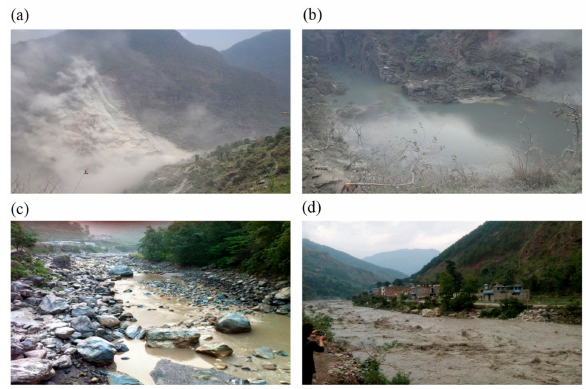
Figure 9. ( a ) Natural landslide dam formation on 24 May 2015 (~56 km upstream of dam), ( b ) lake formation after the blockage of the river, ( c ) downstream fluvial discharge after the blockage of the river, and ( d ) extreme fluvial discharge after breaching of the landslide dam on 25 May 2015 (Source: http: // kathmandupost.ekantipur.com / news / 2015-05-24 / blocked-kali-gandaki-river-flows-